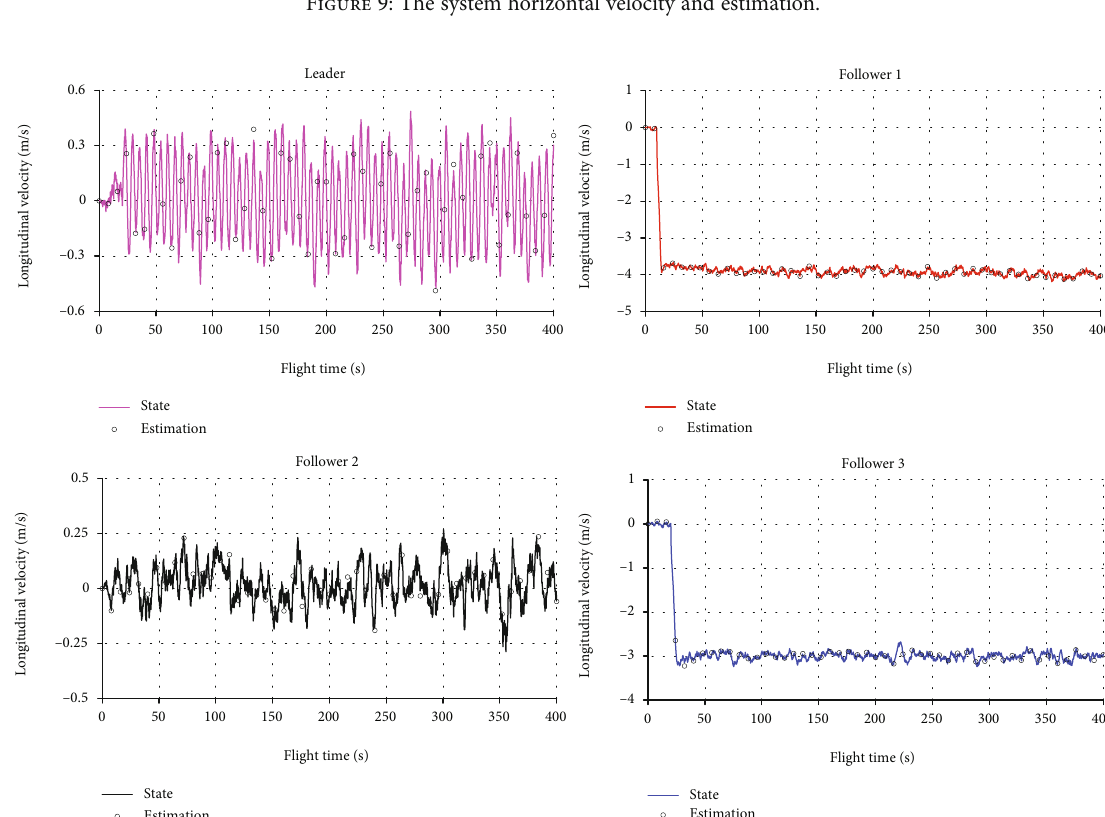
Figure 10: The system longitudinal velocity and estimation.